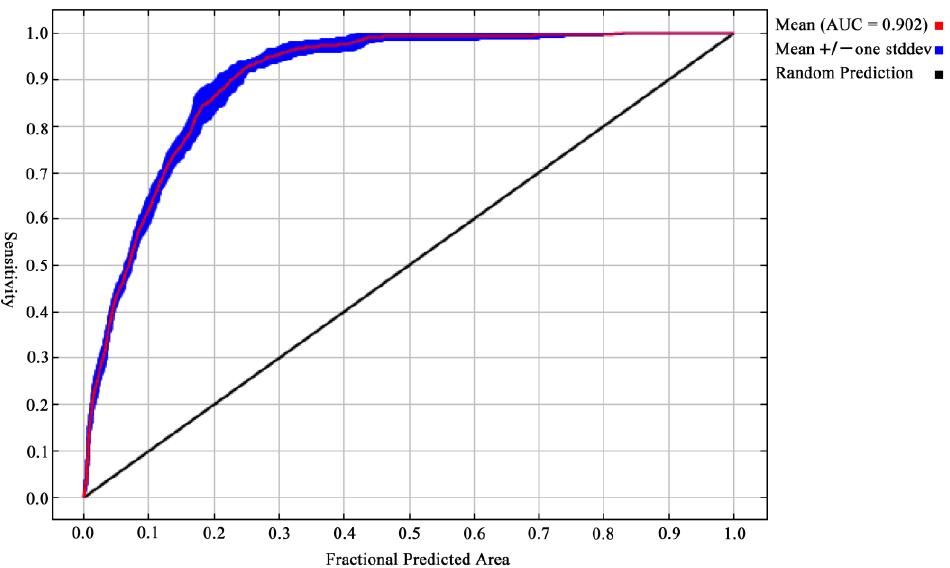
Figure 3. Receiver operating characteristic (ROC) curves and values of the area under the curves (AUC) of the modelling.